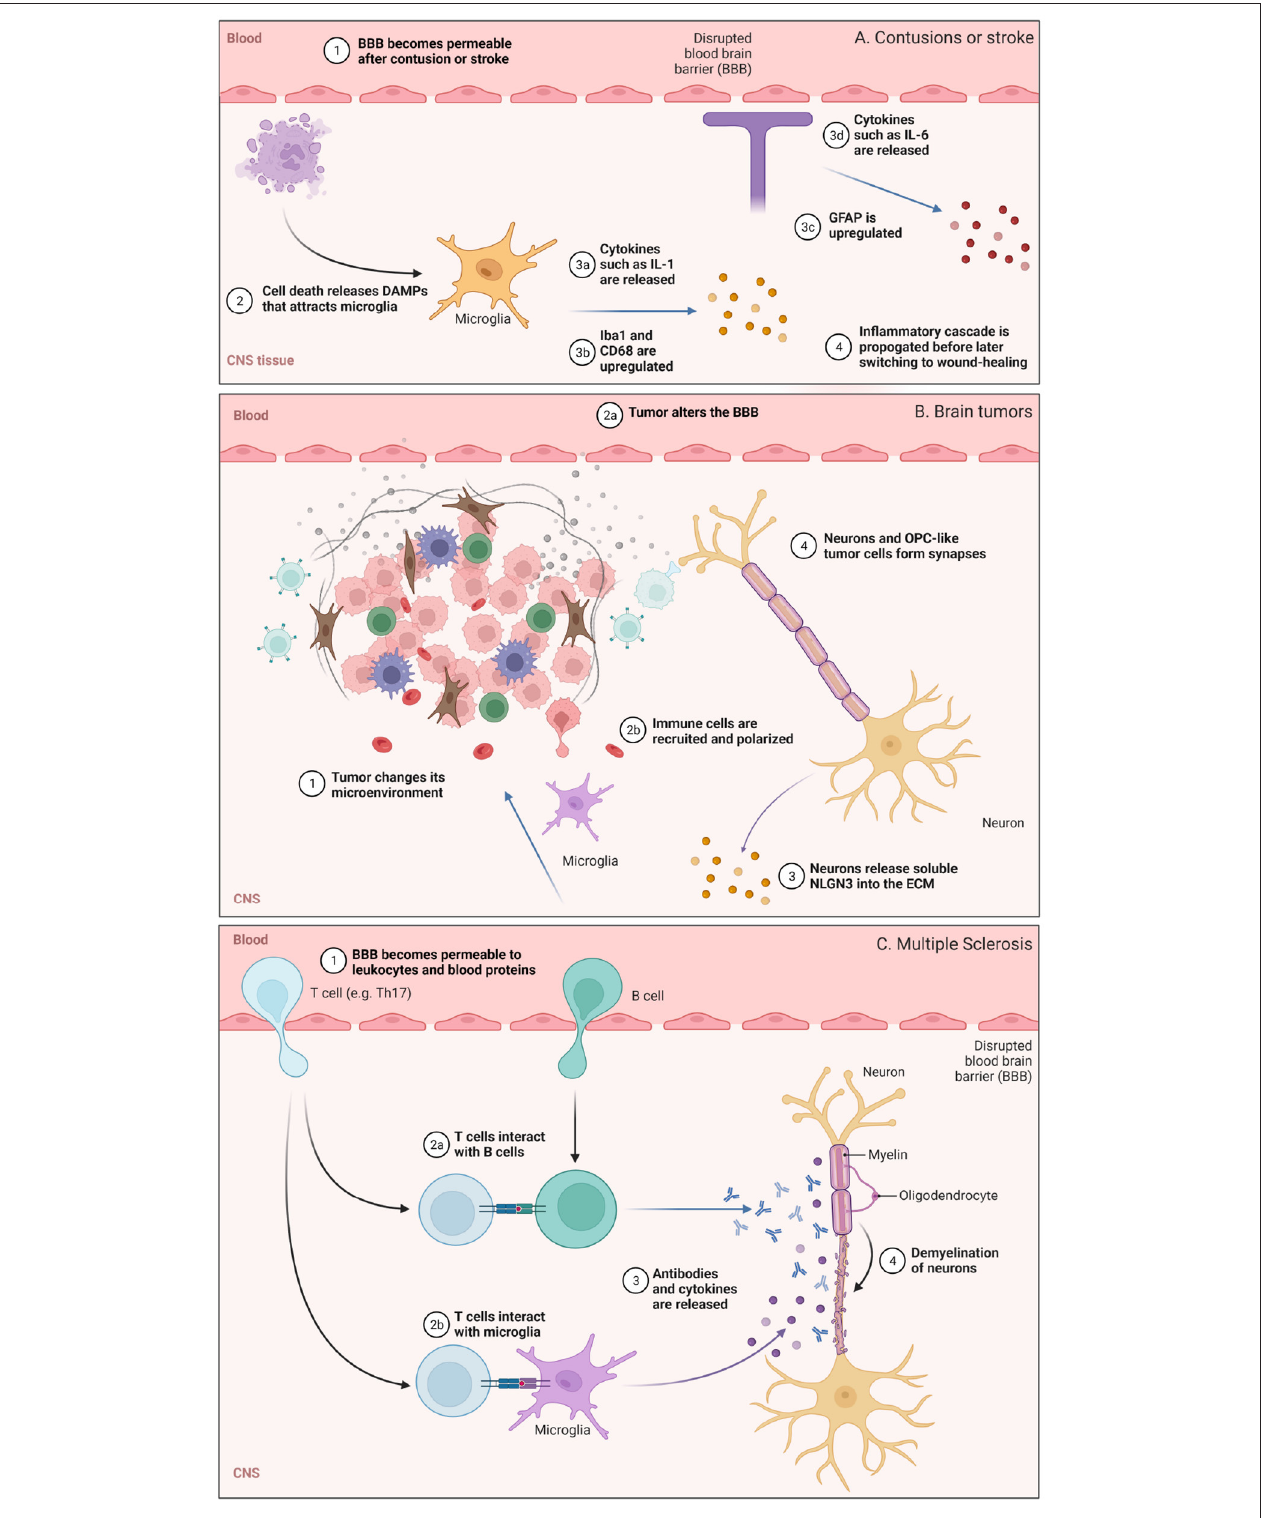
FIGURE 2 | Illustration highlighting some of the cellular or molecular pathways involved in (A) contusions or stroke, (B) glioblastoma (GB), and (C) multiple sclerosis (MS), with events that occur under comparable time scales grouped together. (A) BBB permeabilization and the role of microglia are highlighted. (B) Changes in the brain tumor microenvironment and some neuro-immune consequences. (C) Lymphocyte trafficking into the CNS and subsequent demyelination in MS. Figure made with Biorender.